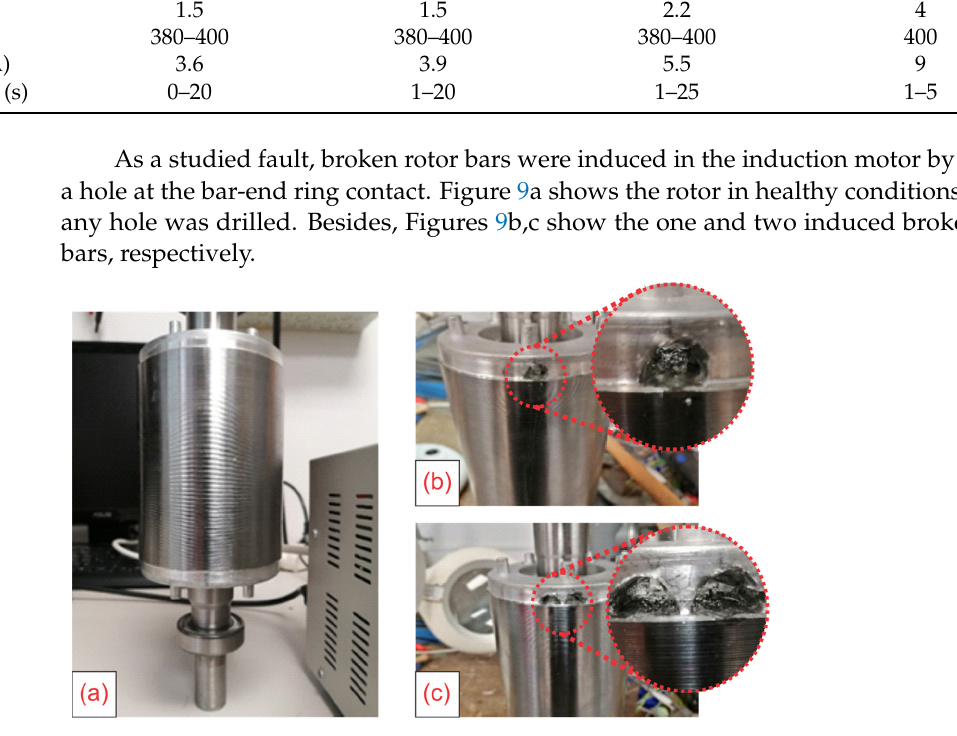
Figure 9. Rotor used during experimentation. ( a ) Healthy. ( b ) One broken bar. ( c ) Two broken bars.